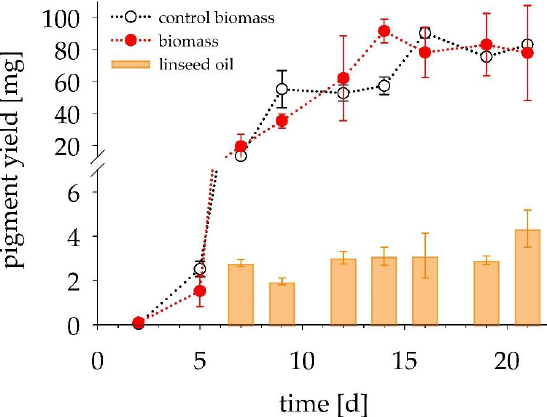
Figure 3. Laetiporic acid yields in biomass and lipophilic phase in 250 mL shake flask culture over the course of the cultivation during in situ extraction. White dots depict the measurements for